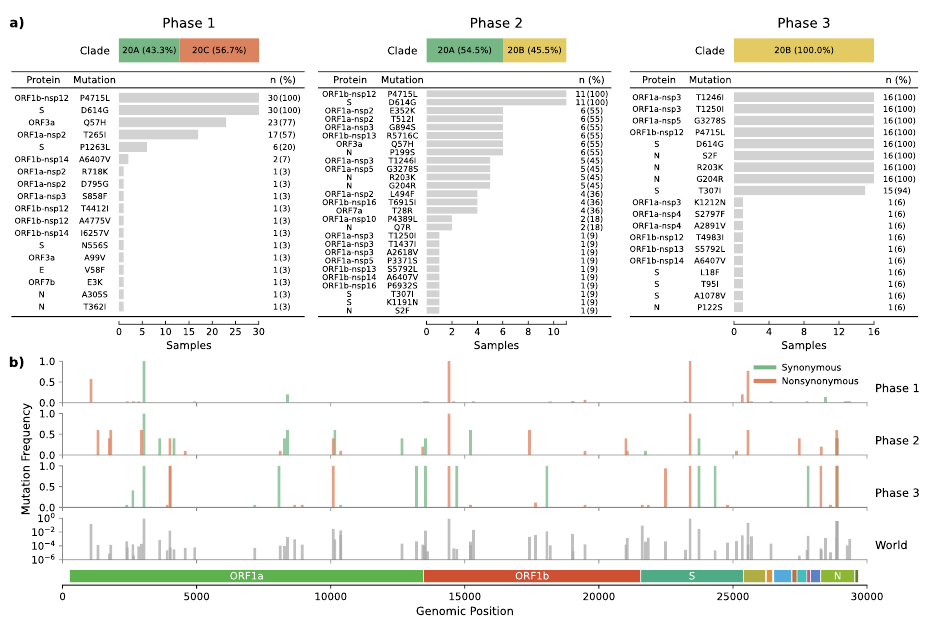
Figure 3. Mutational effect and frequency across epidemic phases. ( a ) Shows the frequency of amino acid changes induced by non-synonymous mutations. ( b ) Depicts the genomic position and relative frequency of both synonymous and non-synonymous mutations during the three epidemic phases the world’s global relative frequency included as a